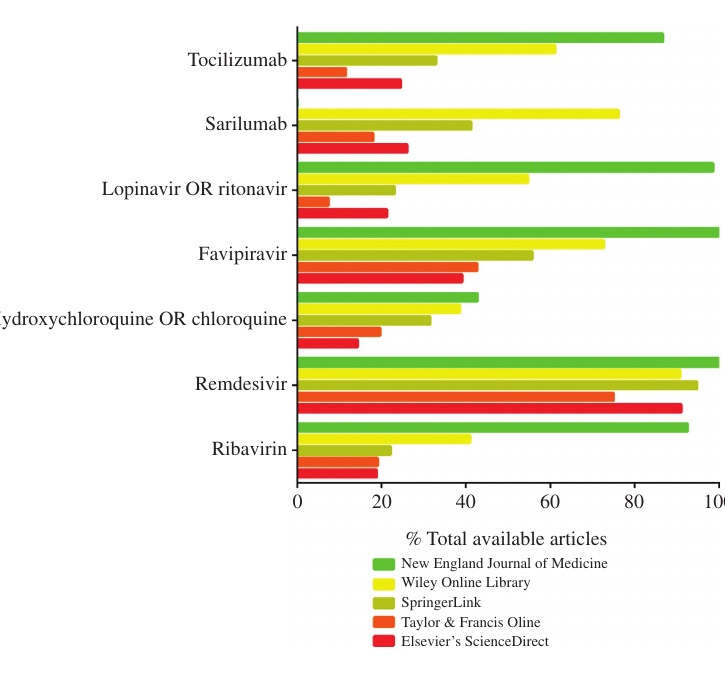
Fig. 1: The availability of research articles relevant to potential drugs of COVID-19 for the public to read for free. The research articles available (expressed as a percentage of the total) to read for free as of 12–17 th April 2020 in Elsevier’s ScienceDirect database ranged between 14.3% to 91.1%, Taylor & Francis Online database ranged between 7.4% to 75%, SpringerLink database ranged between 22.2% to 94.7%, Wiley Online Library ranged between 38.5% to 90.7%, and New England Journal of Medicine ranged between 42.7% and